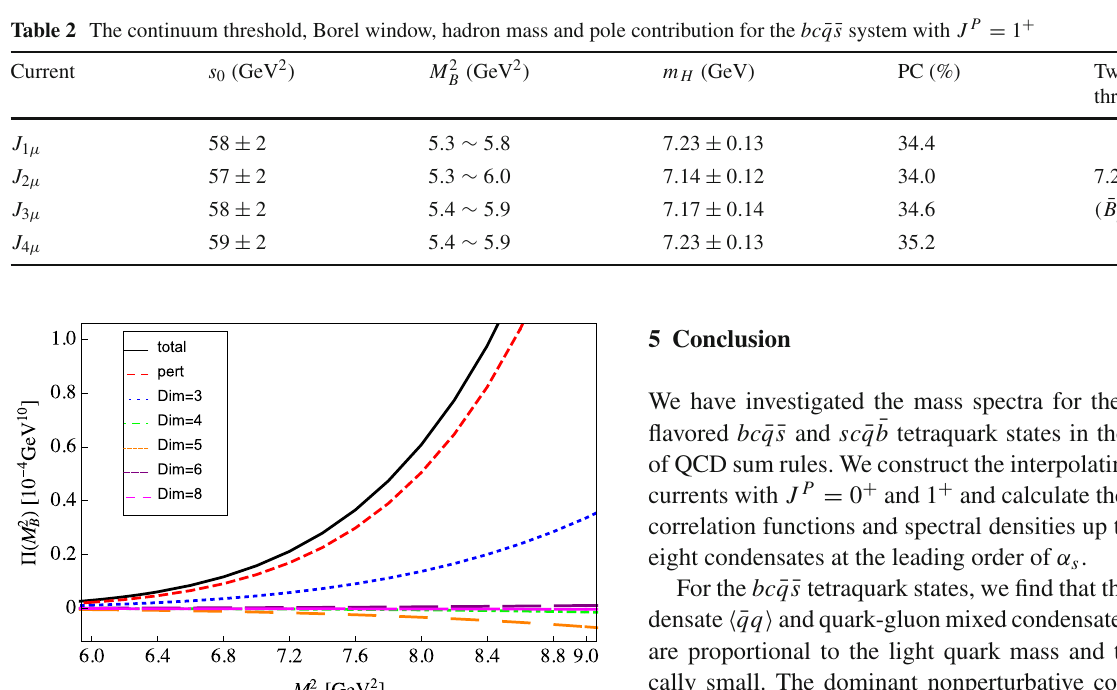
¯ b D and B + K ∗ s c